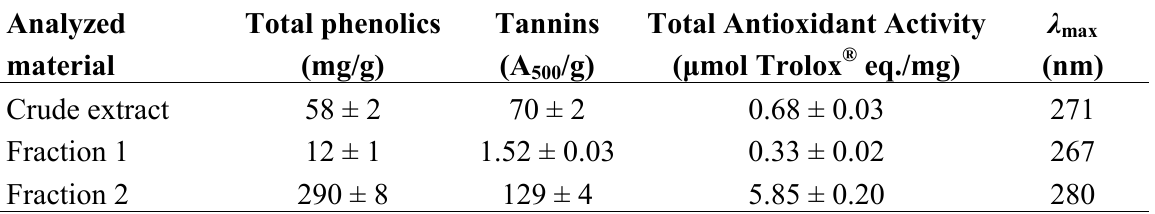
Table 1. Total phenolics content, tannin content, total antioxidant activity, and UV spectral characteristics of a red lentil acetonic extract and its